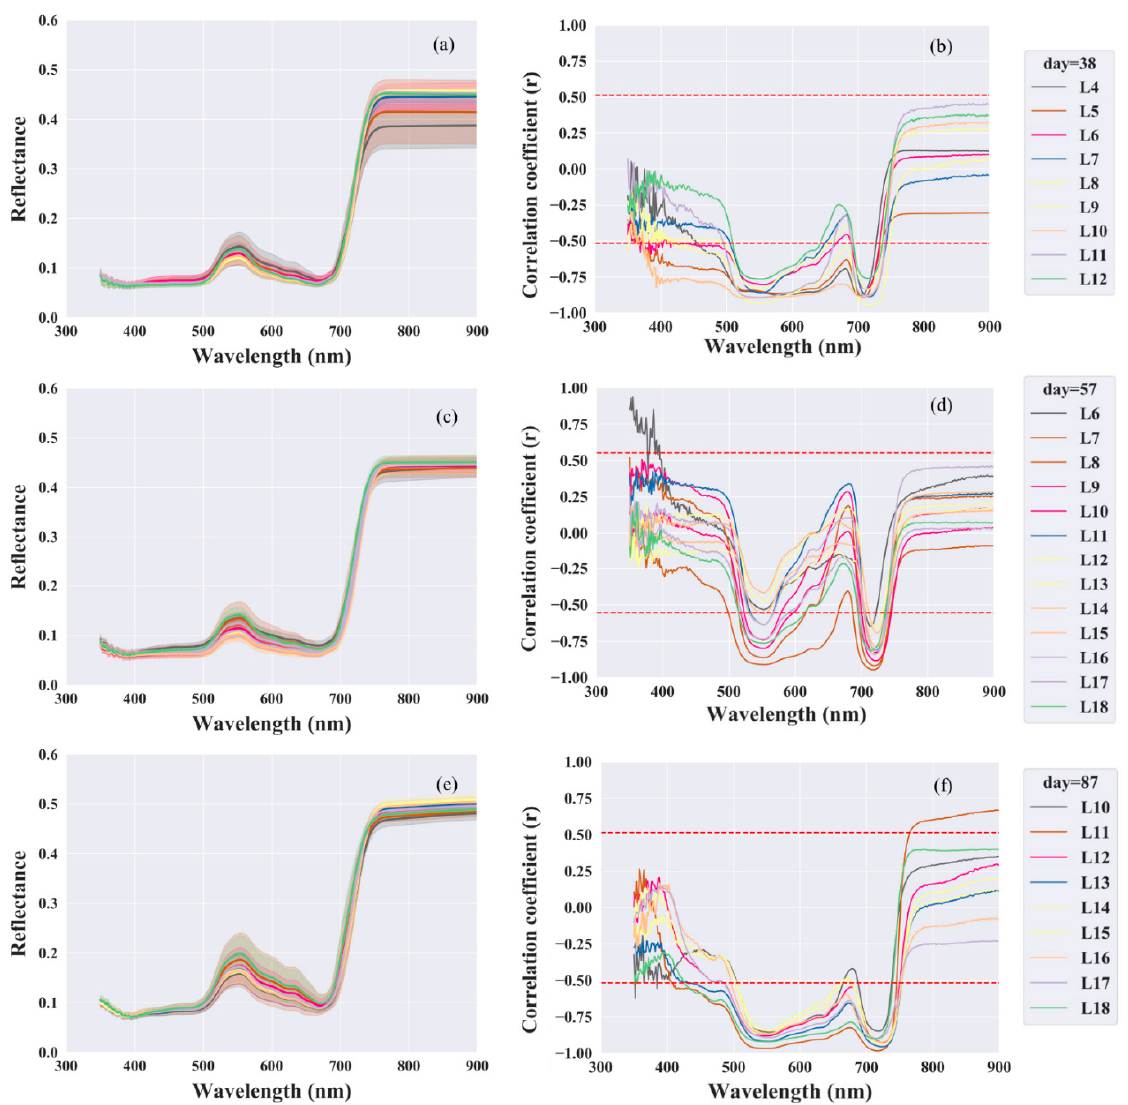
Figure 3. ( a , c , e ) Spectral reflectance curves for leaves at different positions. The standard deviation interval is shaded in gray. ( b , d , f ) Correlation coefficient curve for wavebands and the leaf chlorophyll content (LCC) at different leaf positions. The red dashed line indicates p = 0.05. L1–L18 indicate leaf positions from the bottom to the top of the canopy. Chlorophyll-related reflectance in the range of 350 to 900 nm was used.